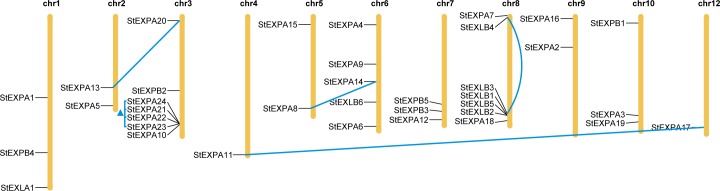
The chromosome positions of potato expansin genes (StEXP).The genes at two ends of blue line mean the potential partial duplicated expansin gene pairs (StEXPA8 and StEXPA14, StEXPA11 and StEXPA17, StEXPA13 and StEXPA20, and StEXLB3 and StEXLB4). The blue triangle indicates the four tandem repeated genes (StEXPA21, StEXPA22, StEXPA23 and StEXPA24).